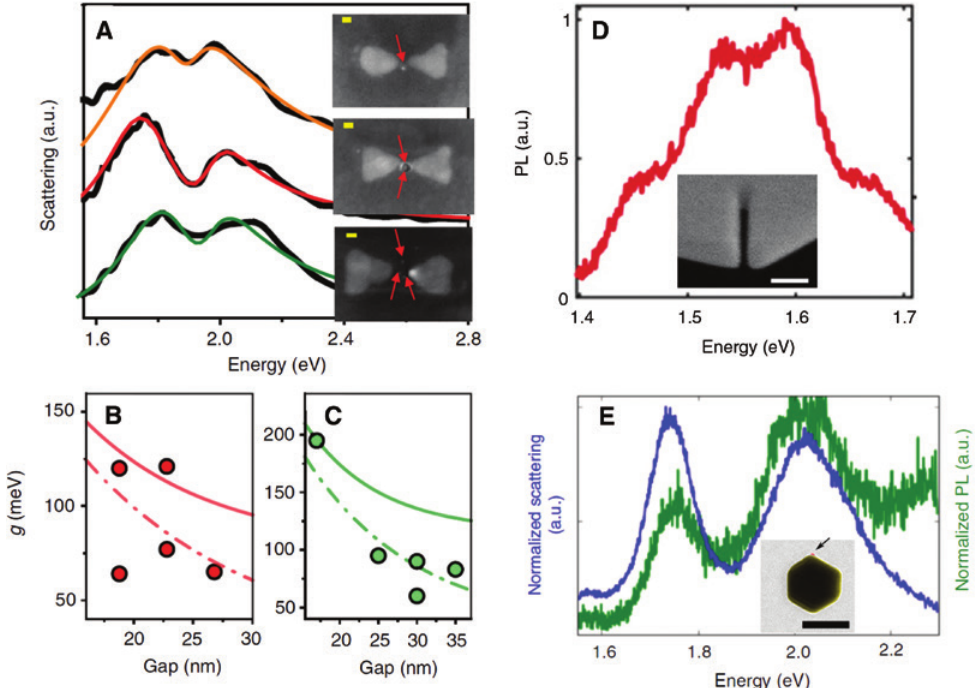
Figure 5: Observing strong coupling. (A) Demonstration of the strong coupling between QDs and the plasmons of silver bowties. Scattering spectra of QD-PC hybrid systems along with their SEM images (scale bars, 20nm) show clear Rabi splitting. The red arrows point to the QDs in in the images. The colored lines are fits of the coupled oscillator model to the experimental data (black lines). (B, C) Dependence of coupling strengths on gap size for bowties with one QD (B) and two QDs (C). The continuous and dashed lines are numerically calculated coupling strengths with the QDs near one of the prisms (continuous lines) or with the QDs at the center of the bowtie (dashed-dotted lines). Panel (A), (B) and (C) are taken with permission from Santhosh et al. [139]. (D) PL spectra of a QD coupled to a plasmonic nanoresonator exhibiting a Rabi doublet due to the involvement of both neutral and charged excitions. Inset: SEM image of the nanoresonator fabricated at the apex of a scanning probe tip (scale bar, 100 nm). (E) Scattering spectra (blue) and PL spectra (green) of a plasmon-emitter system showing Rabi splitting. Inset: SEM images of the plasmon-emitter system. The QD is indicated by an arrow. Panels (D) & (E) are reprinted with permission from Groß et al. [140] and Leng et al. [141],